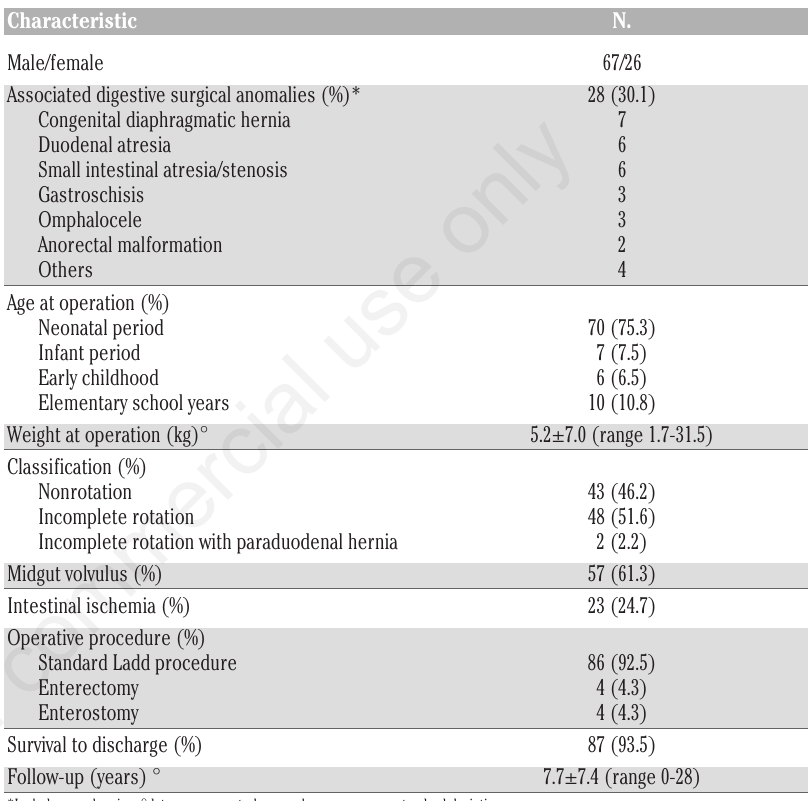
Table 1. Patients characteristics (n=93).